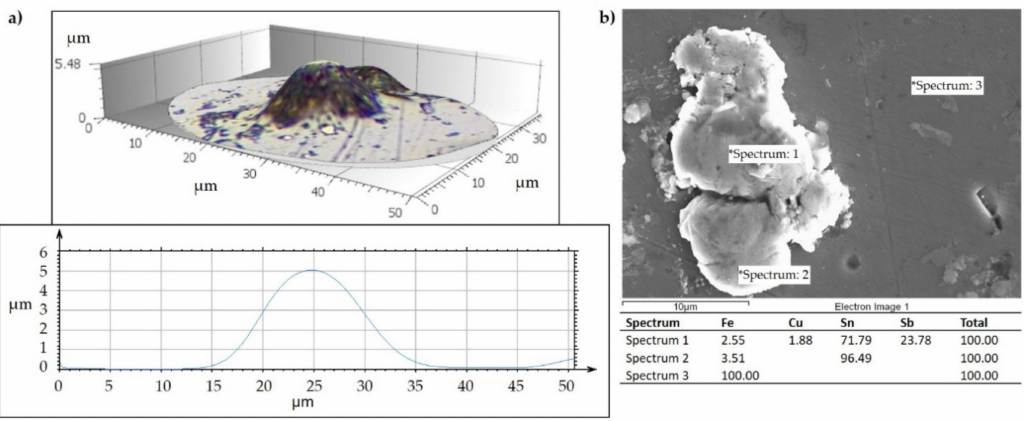
Figure 4. Images of the obtained splats mainly from Sn-Babbitt material: ( a ) 3D-pattern of a splat, ( b ) scanning electron microscopic (SEM) image and the composition of a